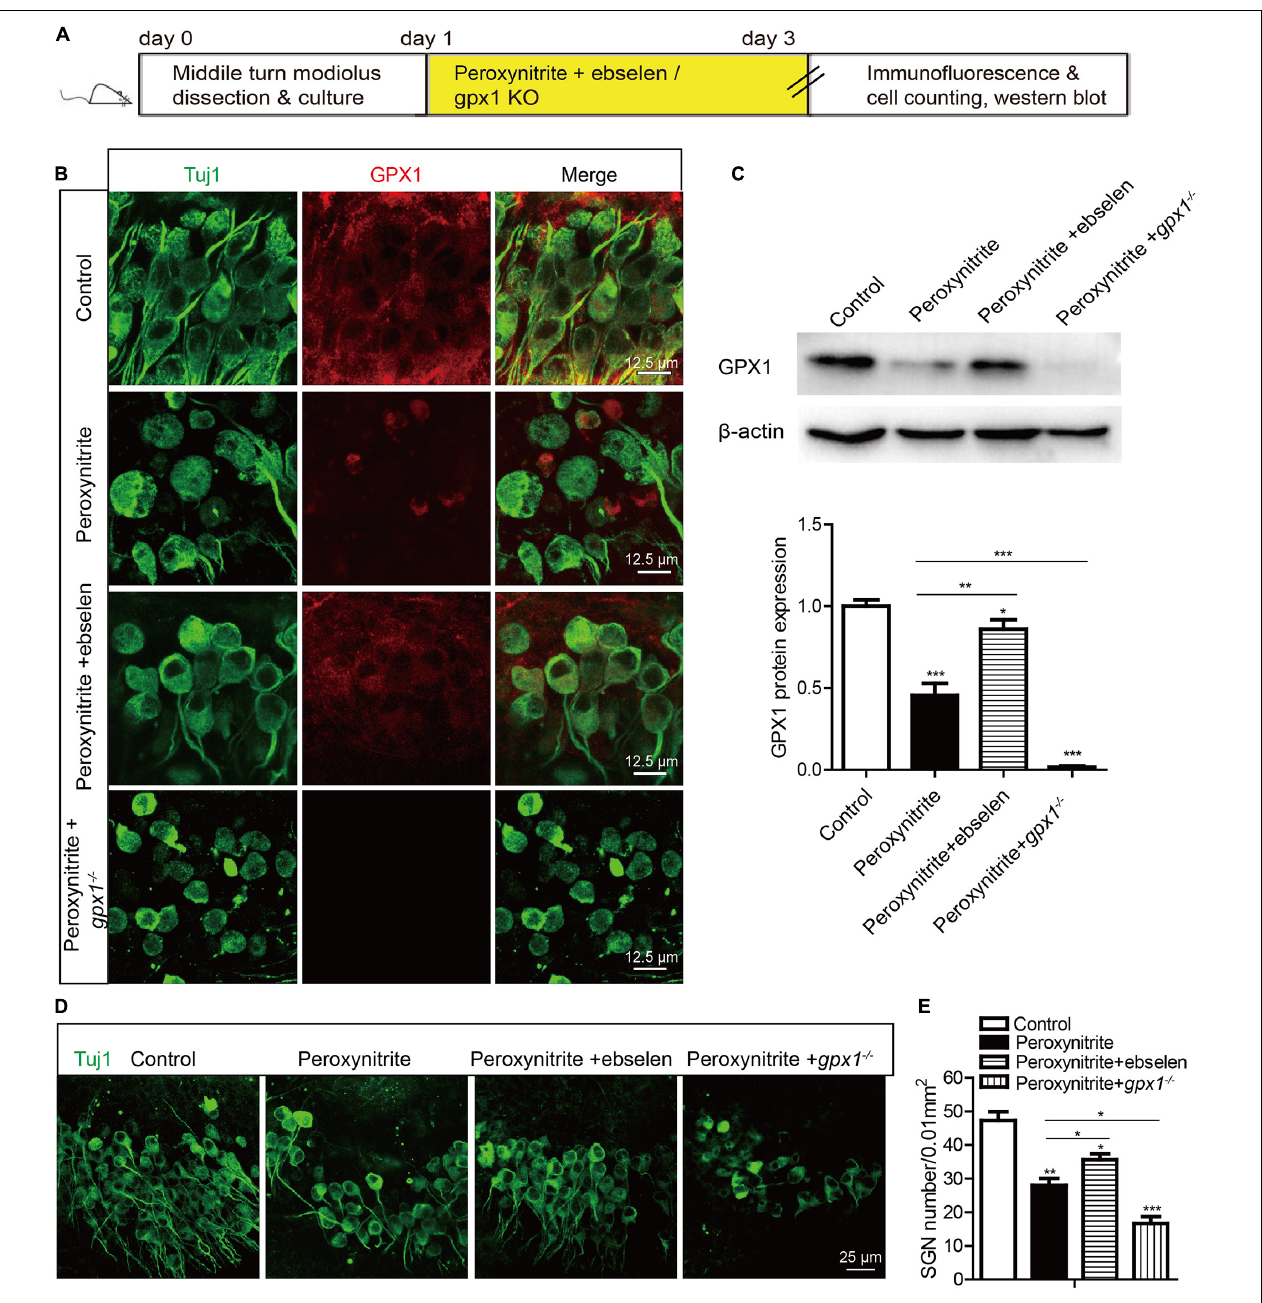
FIGURE 3 | Glutathione peroxidase promotes the survival of SGNs after peroxynitrite damage. The cultured SGNs from P3 WT mice were incubated with 100 µ M peroxynitrite for 48 h with or without pretreatment of 30 µ M ebselen for 1 h, or the SGNs from gpx1 − / − mice were cultured and exposed to 100 µ M peroxynitrite for 48 h. (A–C) Immunofluorescence staining and western blot results showed that the protein expressions of GPX1 were significantly increased in peroxynitrite + ebselen group compared with the peroxynitrite-only group, while it was absent in the peroxynitrite + gpx1 − / − group. Scale bar = 12.5 µ m. (D,E) Immunostaining and cell counting showed that the number of surviving SGNs was significantly increased after pretreatment with ebselen compared with the peroxynitrite-only group, while remarkably less survived SGNs were detected in gpx1 − / − mice group compared with WT mice after peroxynitrite treatment. Scale bar = 25 µ m. * p < 0.05, ** p < 0.01, *** p < 0.001, and n = 3 for each